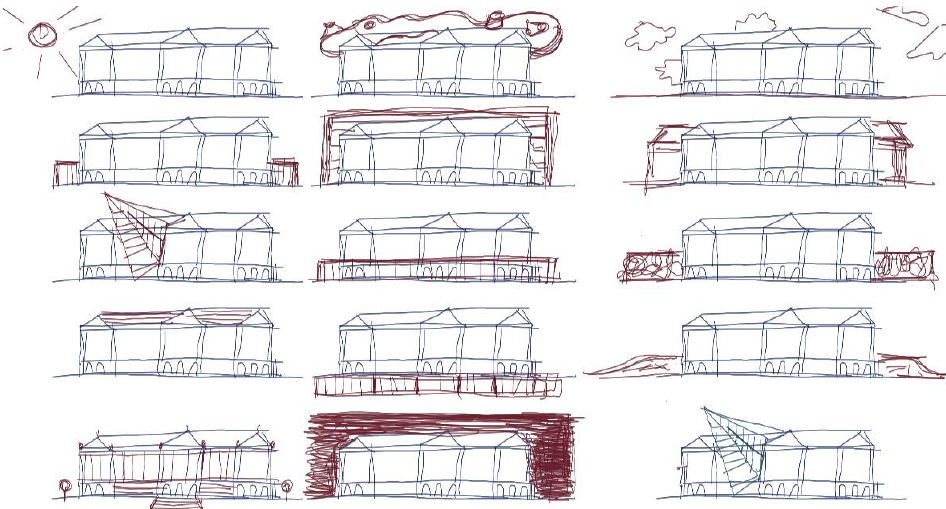
Figure 4. Sketches resulting from a meeting with students. They show various ideas of issues that the students wanted to test by means of an eye tracker. The wide range of presented ideas reflects the astonishingly dynamic discussions that occurred during the meetings.